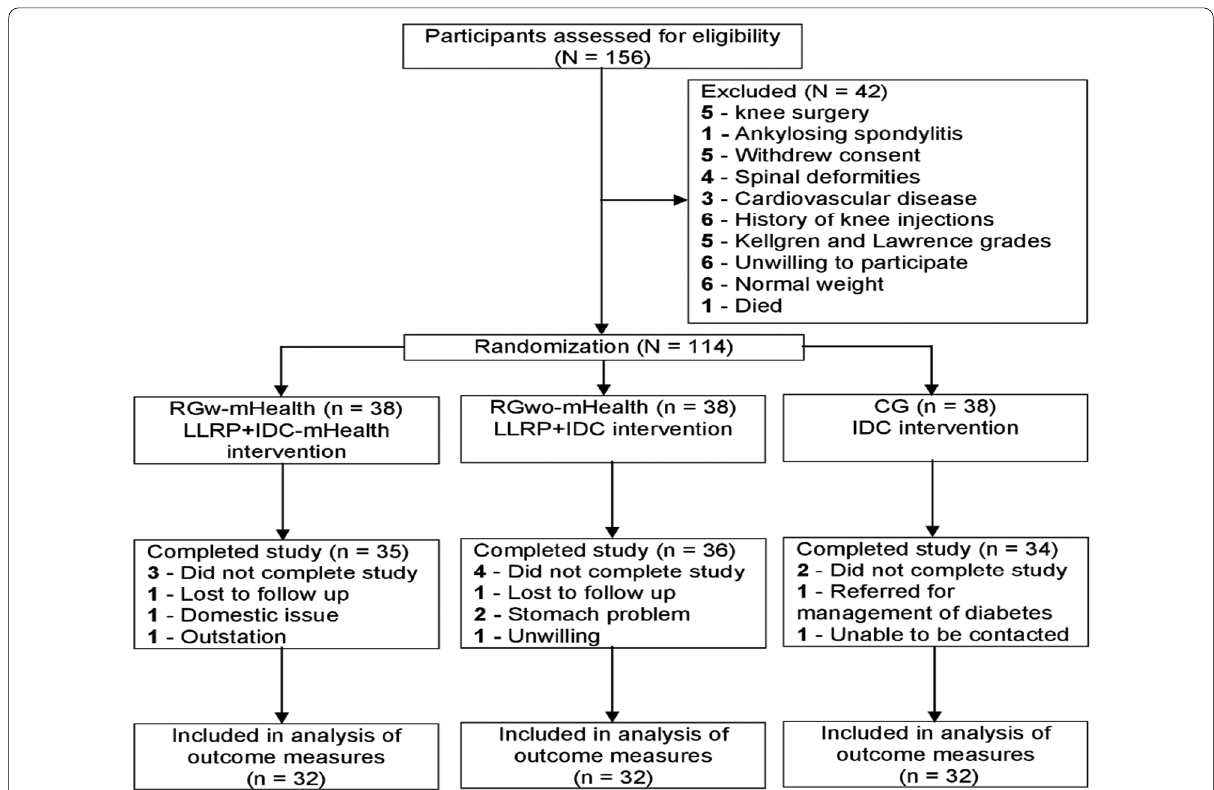
Fig. 1 Study flow diagram: RGw-mHealth Rehabilitation group with mobile health; RGwo-mHealth = CG Control group; LLRP Lower limb rehabilitation protocol; IDC = = protocol plus instructions of daily care combined with mobile